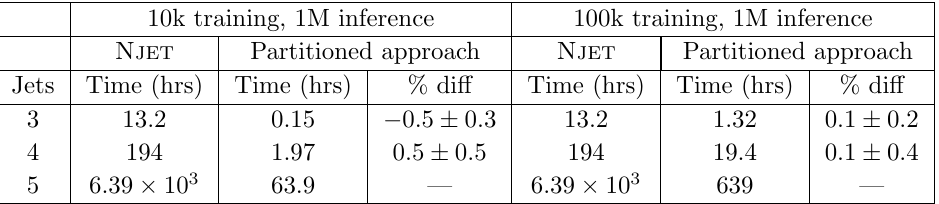
Table 1 . Time required for k-factor calculation at di(cid:11)erent multiplicities requiring 1M points, while training on 10k and 100k points. Performance of the partitioned approach is assessed by calculating the percentage di(cid:11)erence in the cross-section approximation normalised to the Njet result. Errors are calculated by adding the model uncertainty and Monte Carlo error from the Njet result in quadrature. These results assume all calculations take place on a single CPU core and that the training points form part of the inference set. Training on 10k points is fast but not necessarily reliable, whereas using 100k points gives more reliable results and so may be a more reasonable estimate of the speed up. Results are not given for 5-jets since we did not generate testing data at this multiplicity.